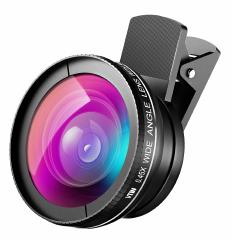
Figure 2: Macro lens for iPad